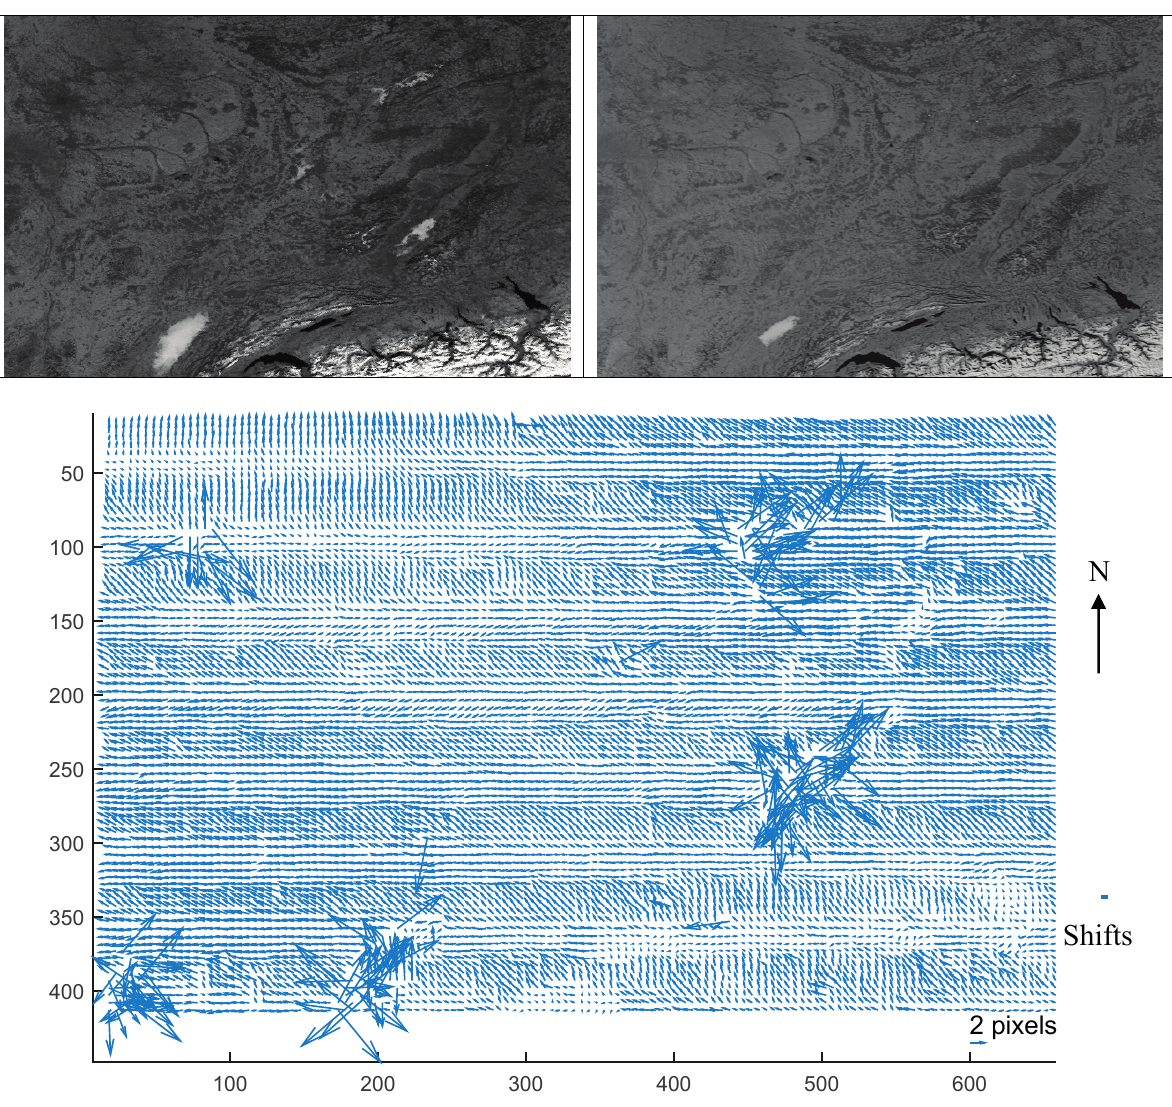
Figure 14. Matching of Band-2 L1B images (input to orthorectification). Top: left NOAA-17 after being co-registered with NOAA-18, right NOAA-18. Bottom: shifts after matching NOAA-17 with NOAA-18. The large vectors correspond to matching errors due to multitemporal differences (e.g., clouds) and significant other differences in grey values due to different illumination conditions, viewing angle, etc . The systematic stripes are clearly visible. They have a width of about 30 pixels, and alternating shifts of about 1 and 0 pixels. The axes in the plot (bottom) denote the image